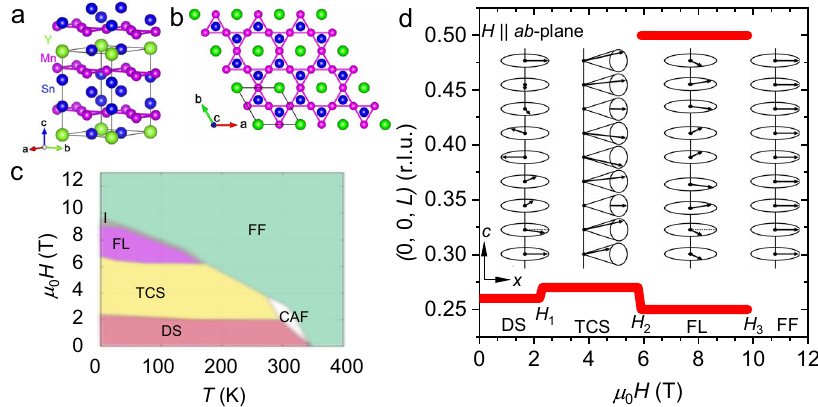
Fig. 1 Crystal structure and magnetic properties of YMn 6 Sn 6 . a Crystal structure of YMn 6 Sn 6 . b c -axis view of the structure showing Mn atoms arranged in a kagome-net in the ab -plane. c Schematic temperature ( T ) and magnetic fi eld ( H ) phase diagram of YMn 6 Sn 6 labeled for the various magnetic phases for fi eld applied in the ab -plane including the distorted spiral (DS), transverse conical spiral (TCS), fan-like (FL), and forced ferromagnetic (FF) phases. Small pockets labeled as I and CAF represent phase I and the canted antiferromagnetic phase, respectively. d Plot of the wavevector ( L = k z ) of the magnetic Bragg peaks observed in neutron diffraction experiments at 10 K (red lines) and illustrations of the magnetic structures for DS, TCS, FL, and FF phases. Magnetic fi elds at which transitions from DS to TCS, TCS to FL, and FL to FF are indicated by H 1 , H 2 , and H 3 , respectively. Arrows represent the direction of spins in each Mn-layer. The labels c and x represent c -axis and the direction of magnetic fi eld in the ab -plane,